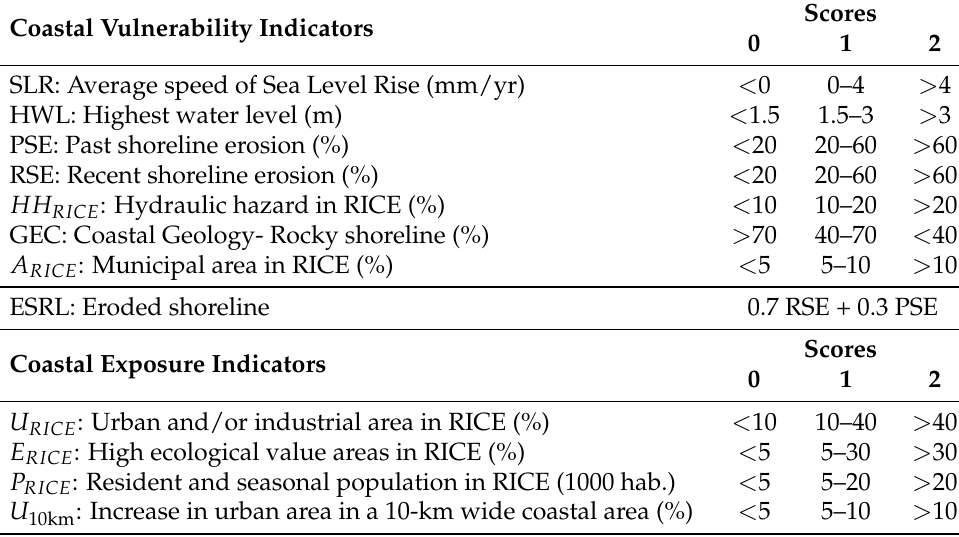
Table 1. Ranking scores of CVI and CEI used in Mod.E.M.